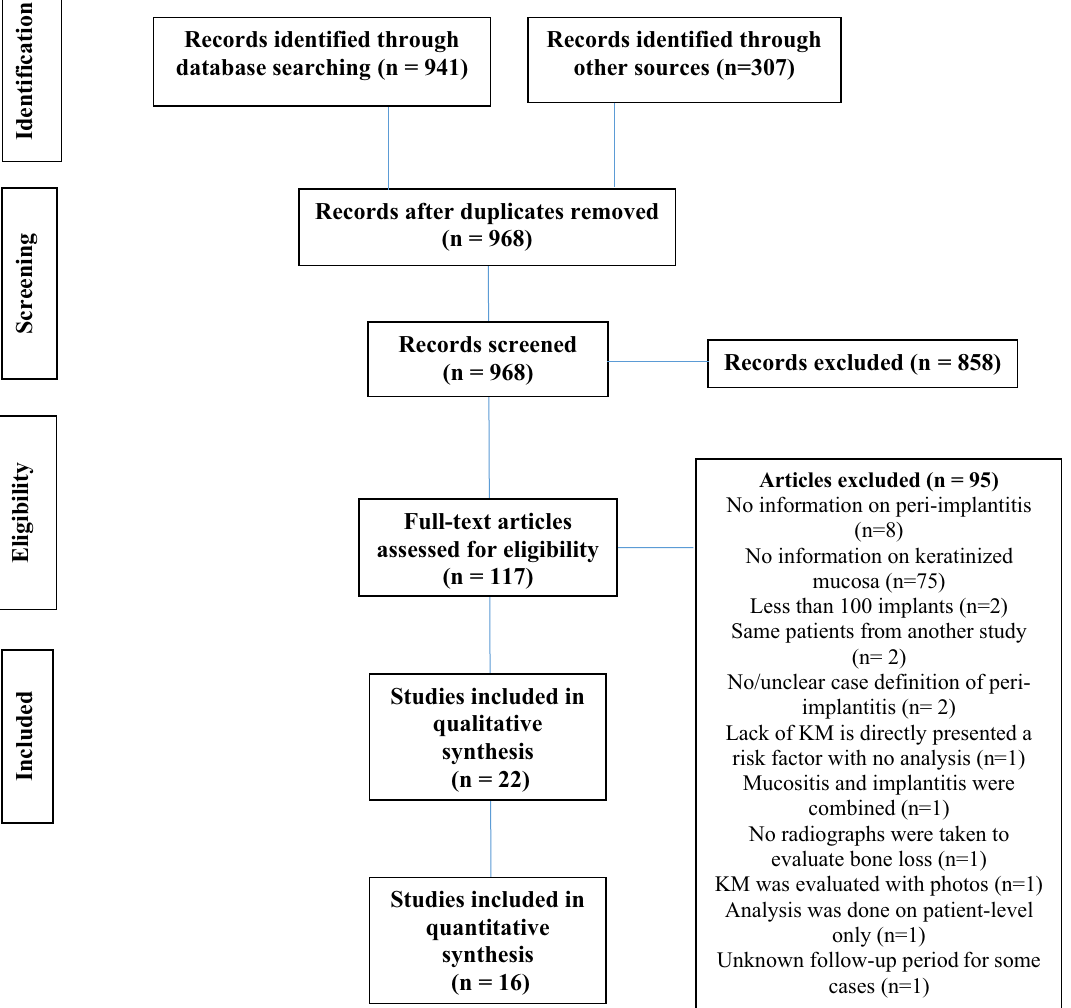
Figure 1. PRISMA flowchart of the search process and